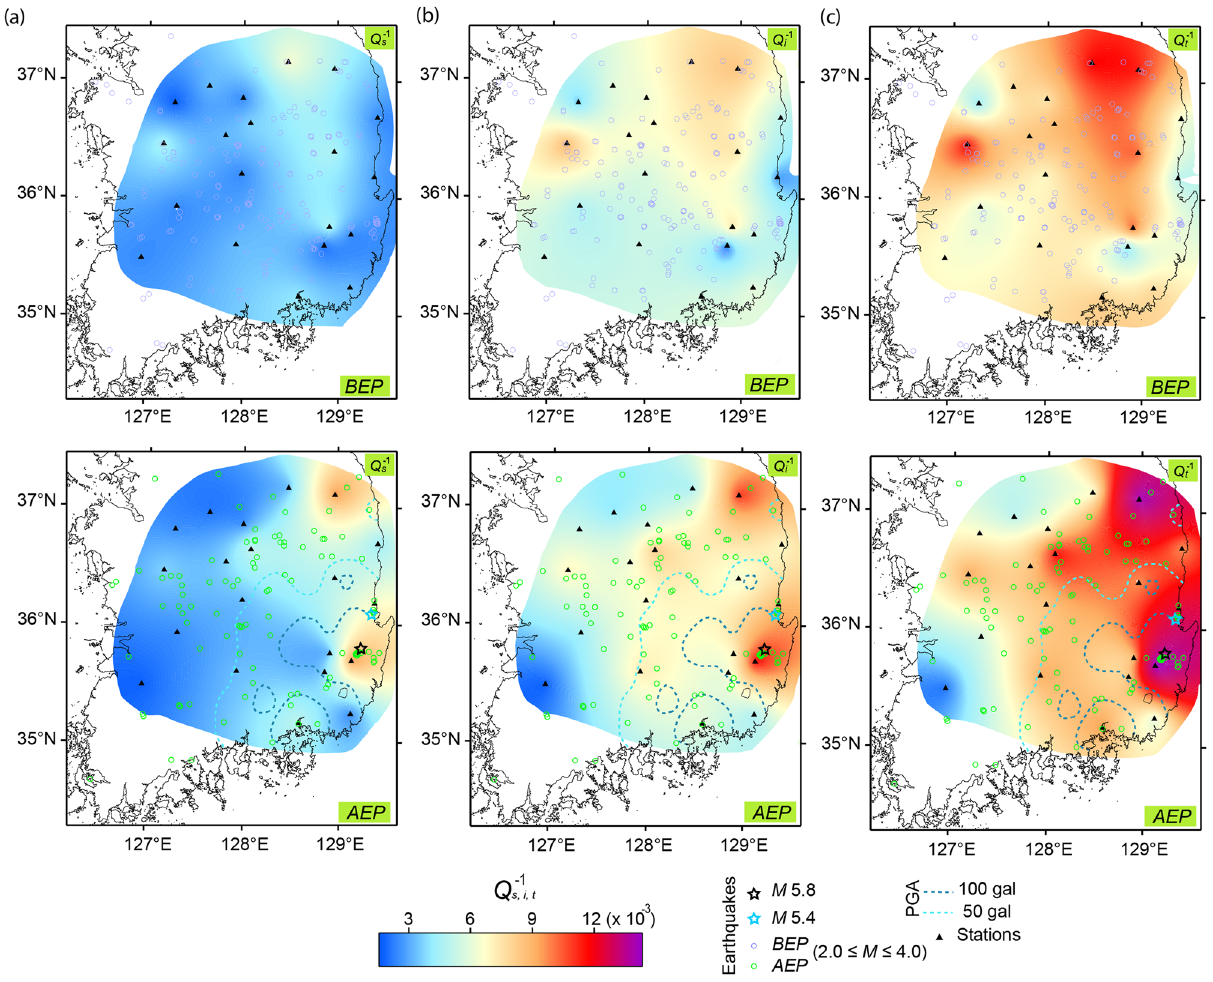
Figure 4. Map of the ( a ) Q s –1 , ( b ) Q i –1 , and ( c ) Q t –1 value at 1.5 Hz in the BEP (top) and AEP (bottom) for the Gyeongju earthquake ( M 5.8). The styles and symbols are the same as those in Fig.